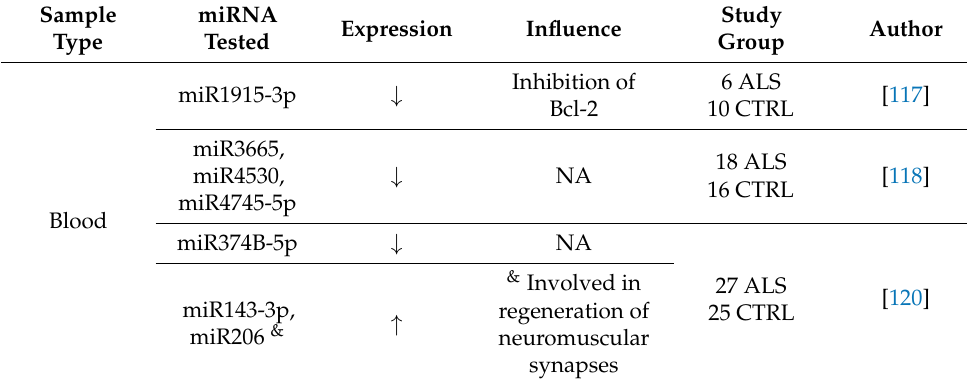
Table 3. Molecular biomarkers of